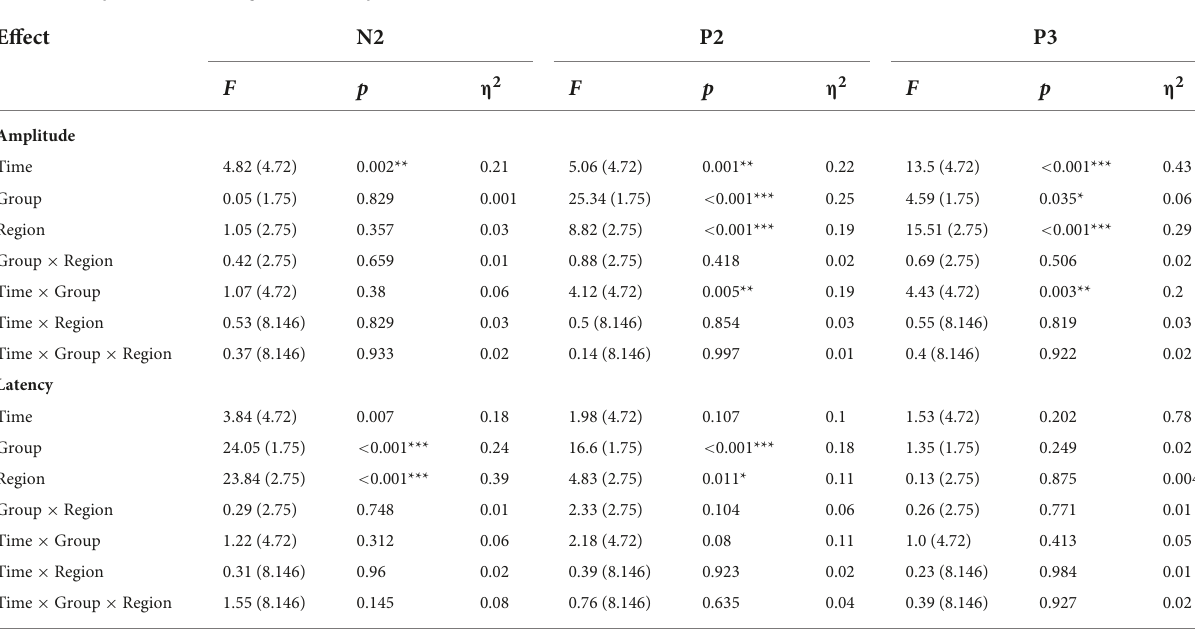
TABLE 4 Amplitude and latency of ERPs component for Oddball task.